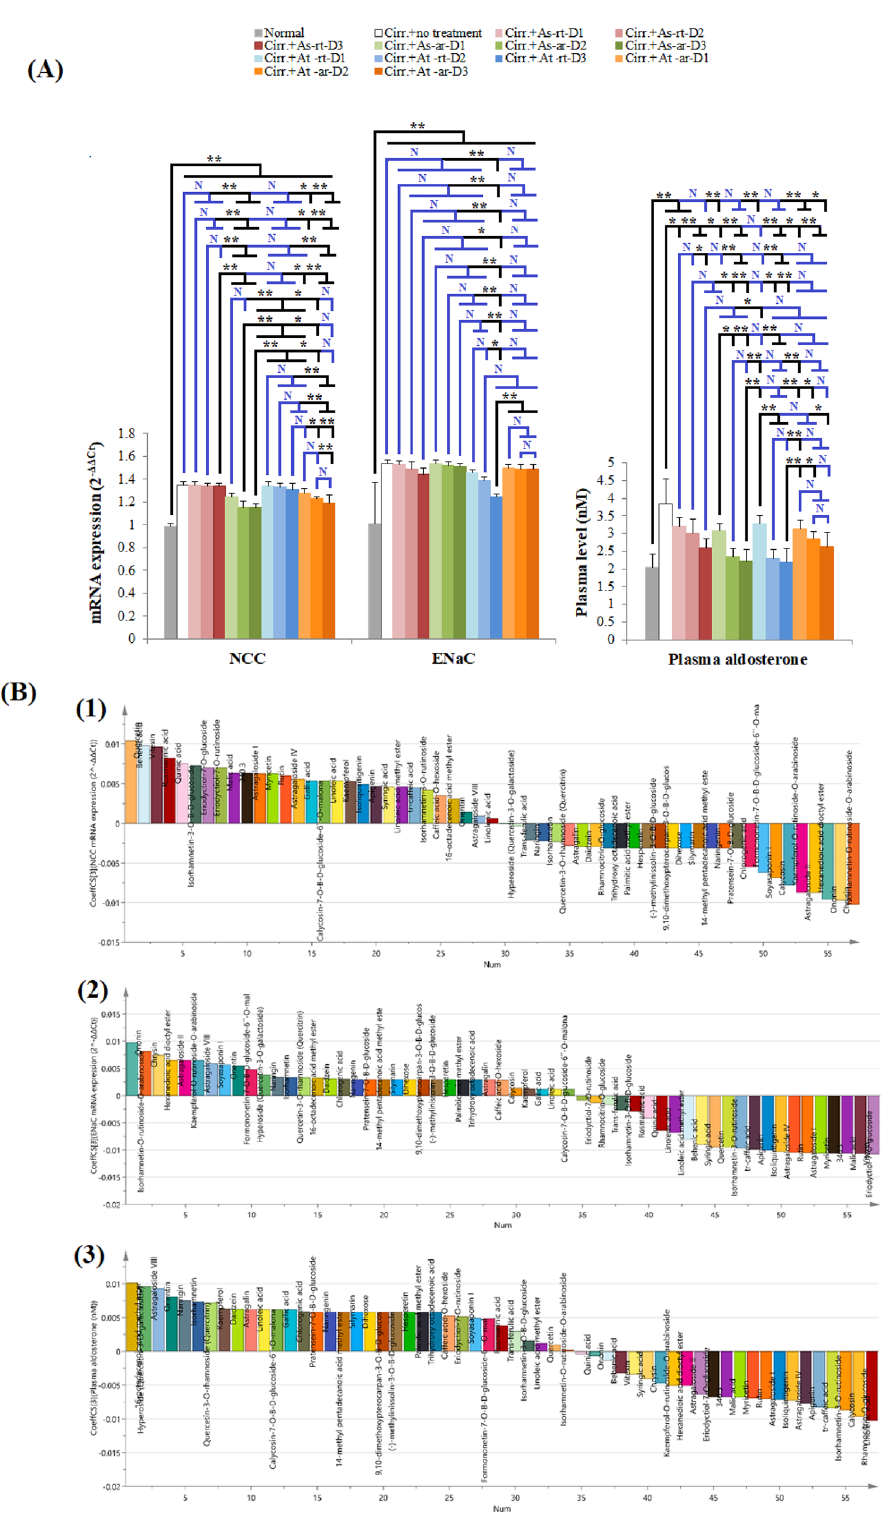
Figure 7. The effect of different Astragalus extracts on mRNA expression of the distal convoluted tubule transporters and collecting ducts mechanisms and their coefficient plot of OPLS model. ( A ): Effect of different Astragalus extracts on the expression of different renal transporters of the distal convoluted tubule and collecting ducts mechanisms, ( B ): Coefficient plot of OPLS model for diuretic mechanisms; (1) NCC (2) ENaC (3) aldosterone. ANOVA test was used to compare between the different groups with Post Hoc Test (Tukey) to compare different groups. *: Statistically significant at p ≤ 0.05, **: Statistically significant at p ≤ 0.001, N: Statistically non- significant ( p > 0.05), n = 8; all results are presented as mean ± SD. (Cirr.: induced cirrhosis by i.p. administration of CCl 4 (diluted 1:6 with mineral oil) as follows: The first 10 doses were received every 5 days, the subsequent 10 doses were administered every 4 days, and the last 7 doses were given every 3 days, As: Astragalus spinosus , At: Astragalus trigonus , ar: aerial organs, rt: root organs, D1: low dose, D2: medium dose, D3: high dose, NCC: sodium-chloride symporter and ENaC: epithelial sodium